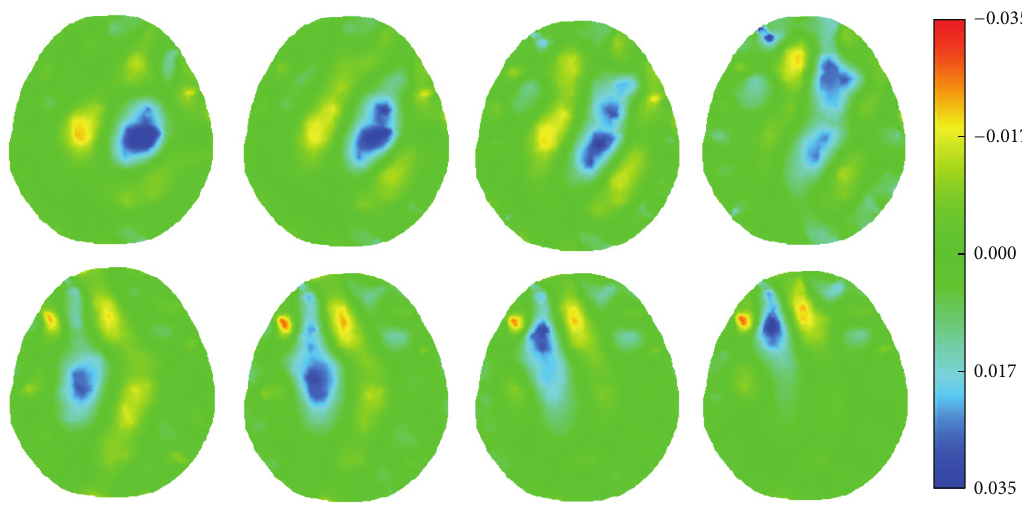
Figure 26: SEIT reconstructions of a simulated ischemic lesion at different locations of the